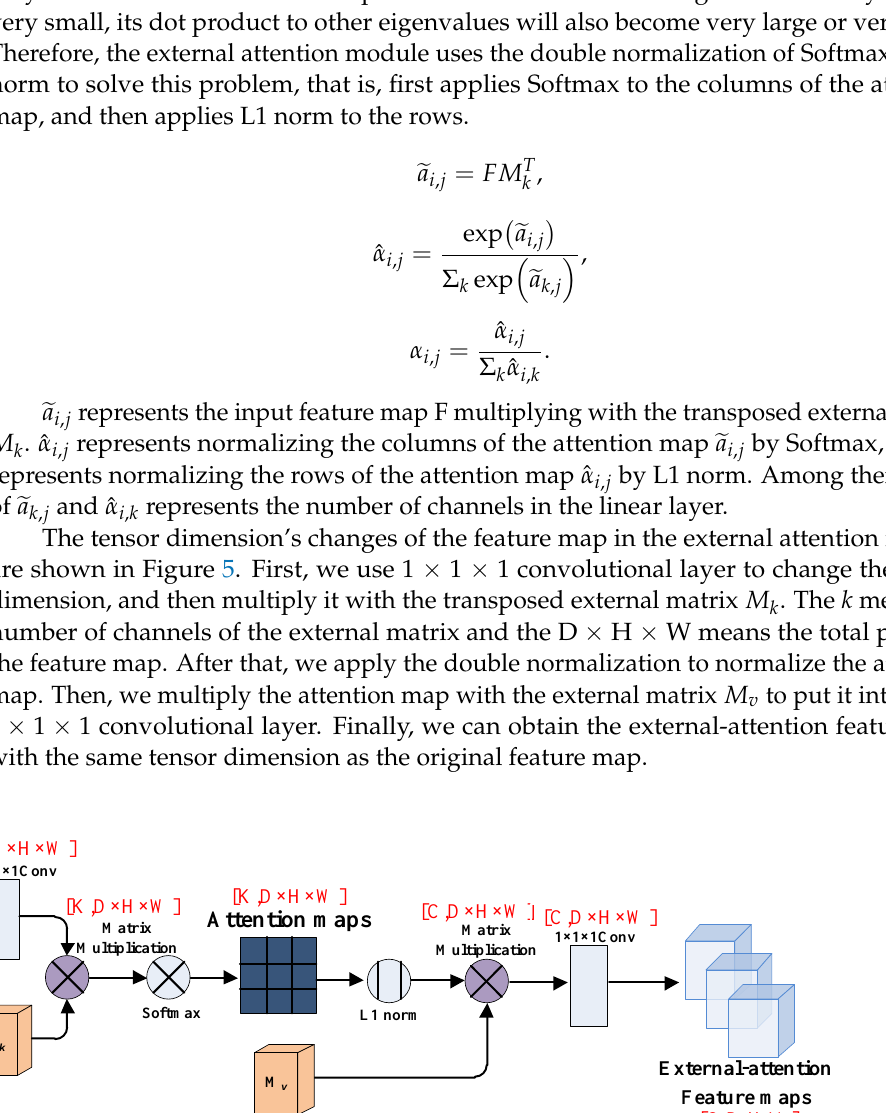
S a m p l e s Figure 6. The FCN model’s framework. Because convolution operation reduces the output size of the input layer, each Patch will generate two scalar values after being trained by the FCN model. Then they are con- verted into the Alzheimer’s disease probability and normal cognitive probability of the corresponding pixel under the action of the activation function Softmax. The disease state of the brain’s local structure is displayed through each pixel’s risk probability value of Alzheimer’s disease. The corresponding feature information of the disease probability